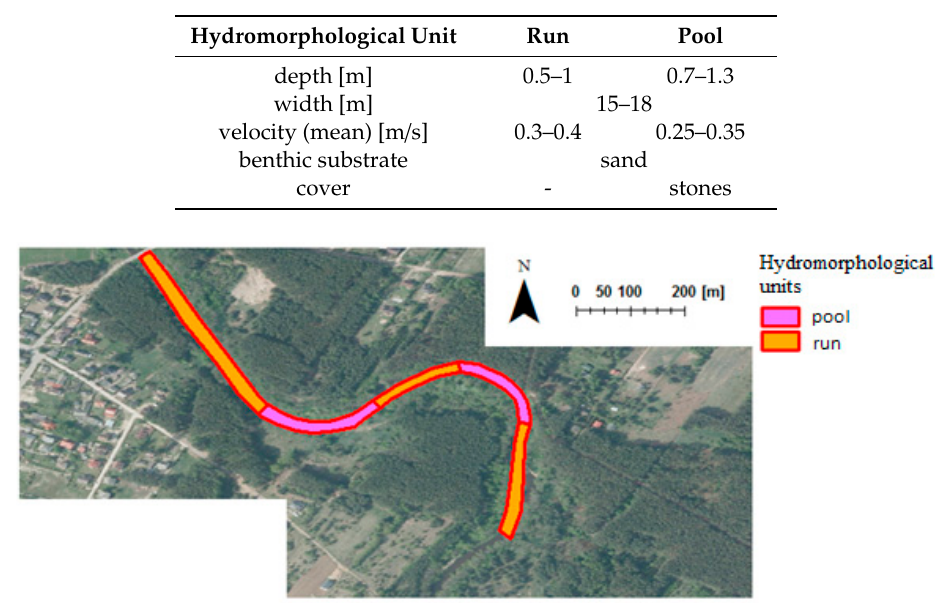
Figure 3. Hydromorphological units obtained after simulating maintenance works on the analyzed section of the Swider River.